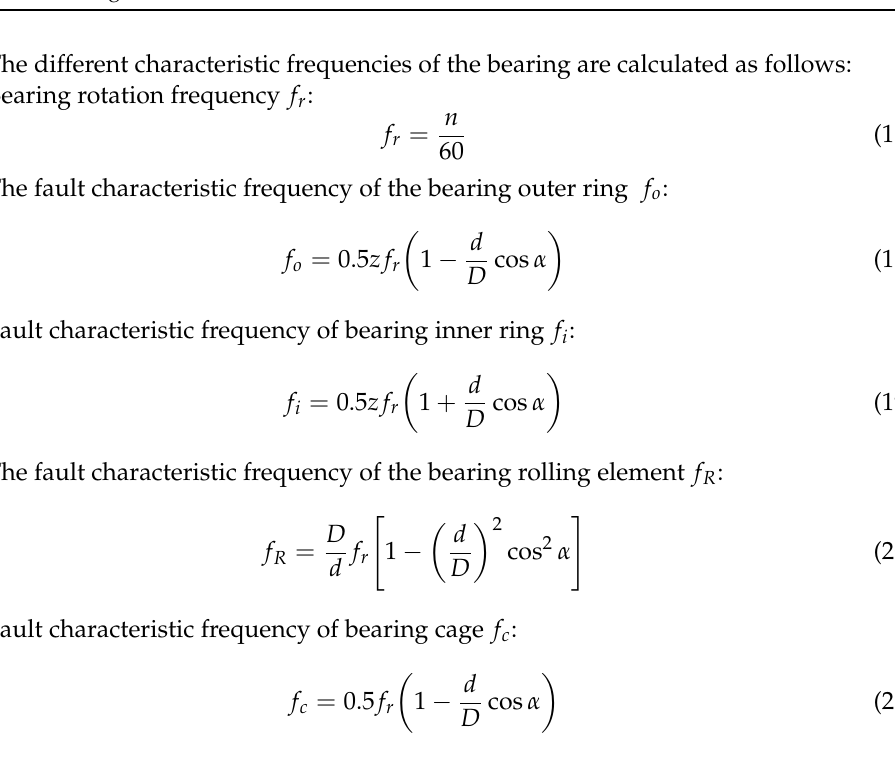
Table 1. Parameters of Bearing 2_1 and Bearing 3_1. Parameter Value Parameter Value Diameter of bearing rolling 7.92 Diameter of inner raceway/mm 29.30 element/mm The number of bearing 8 Diameter of outer raceway/mm 39.80 rolling element The pitch diameter of the 34.55 contact angle/ ◦ bearing/mm